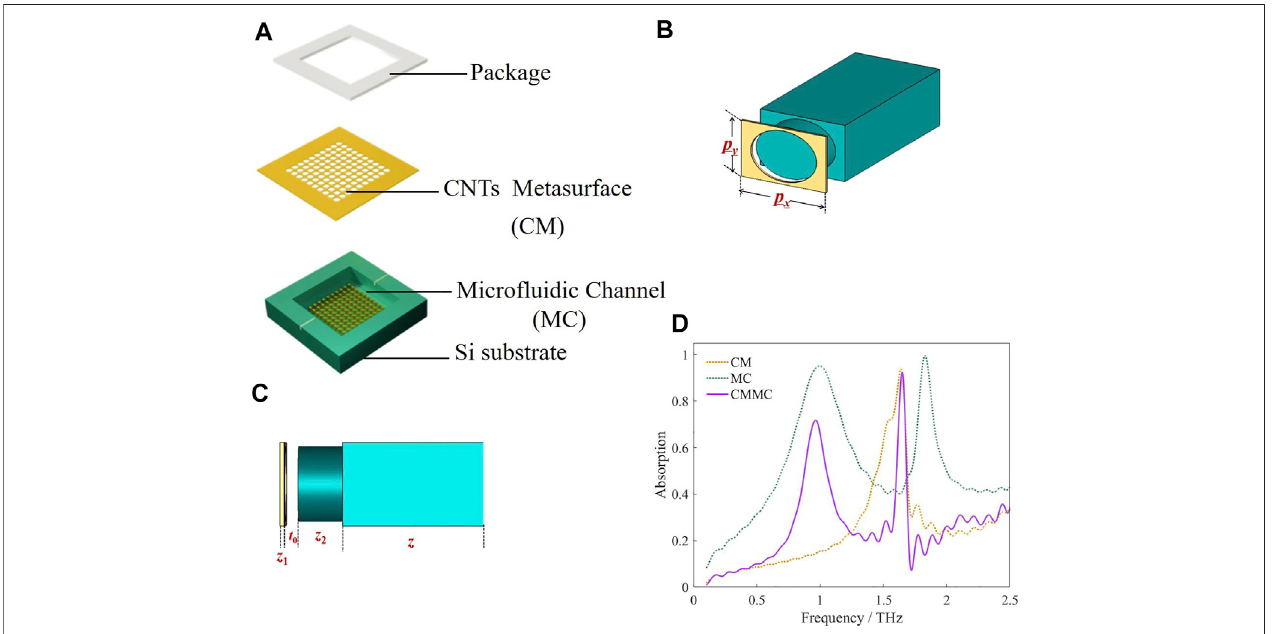
FIGURE1 |(A) Illustration ofthe CMMC. (B) The unit cell geometry ofthe CMMC. (C) The side viewof theunit cell of theCMMC. (D) The absorptionspectra ofthe CMMC and other two structures only with CM or MC.